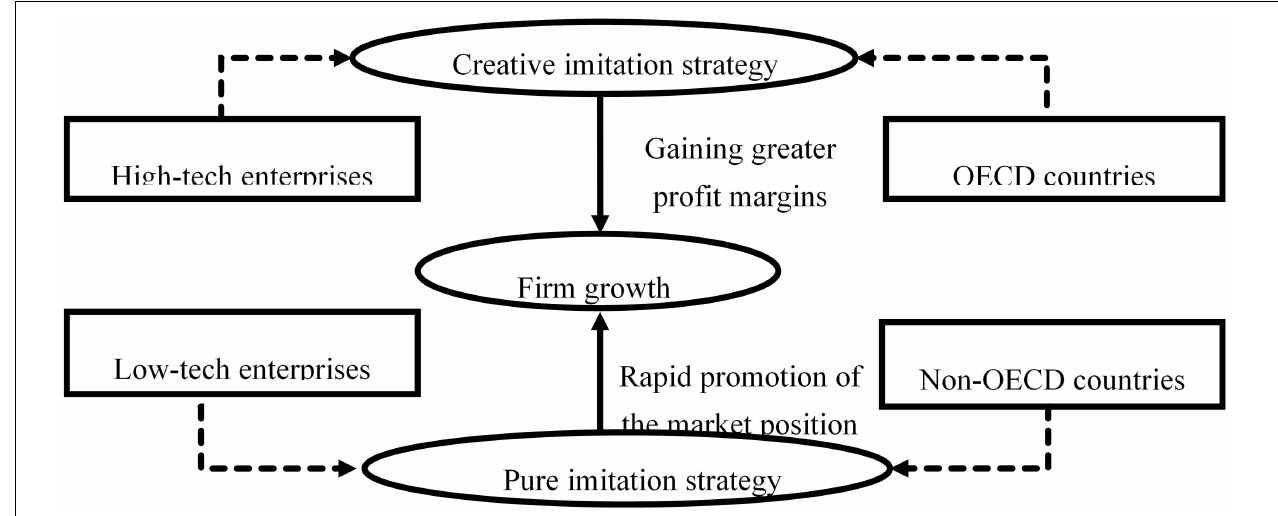
FIGURE 4 | Specific selection of imitation strategy for firm growth based on the external environments of